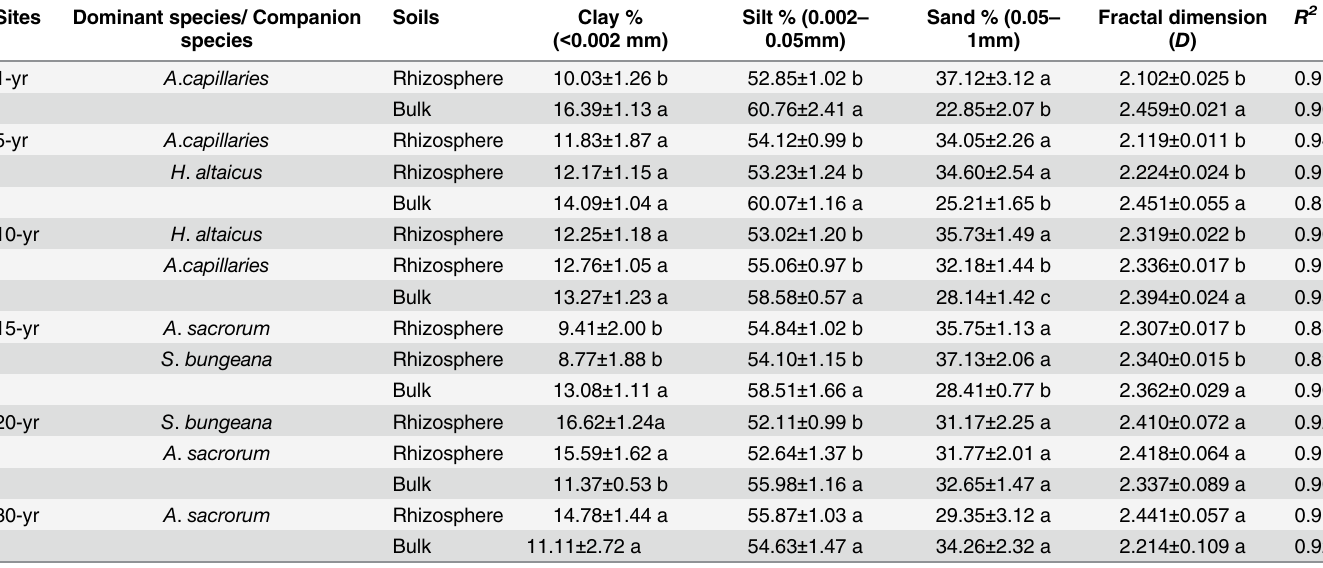
Table 3. Particle size distribution (PSD) and fractal dimension ( D ) of rhizosphere soil and bulk soil during the natural succession.